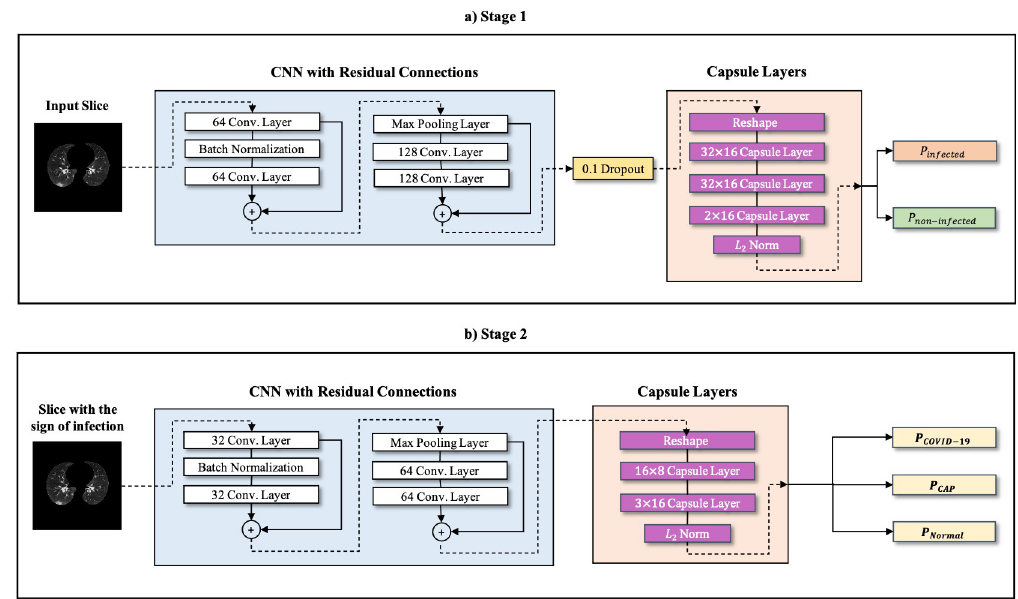
Fig 3. Detailed architecture of the classification model. a) The structure of the CapsNet binary classifier in stage 1. b) The structure of the three-way classifier in stage 2. + sign denotes the residual addition.